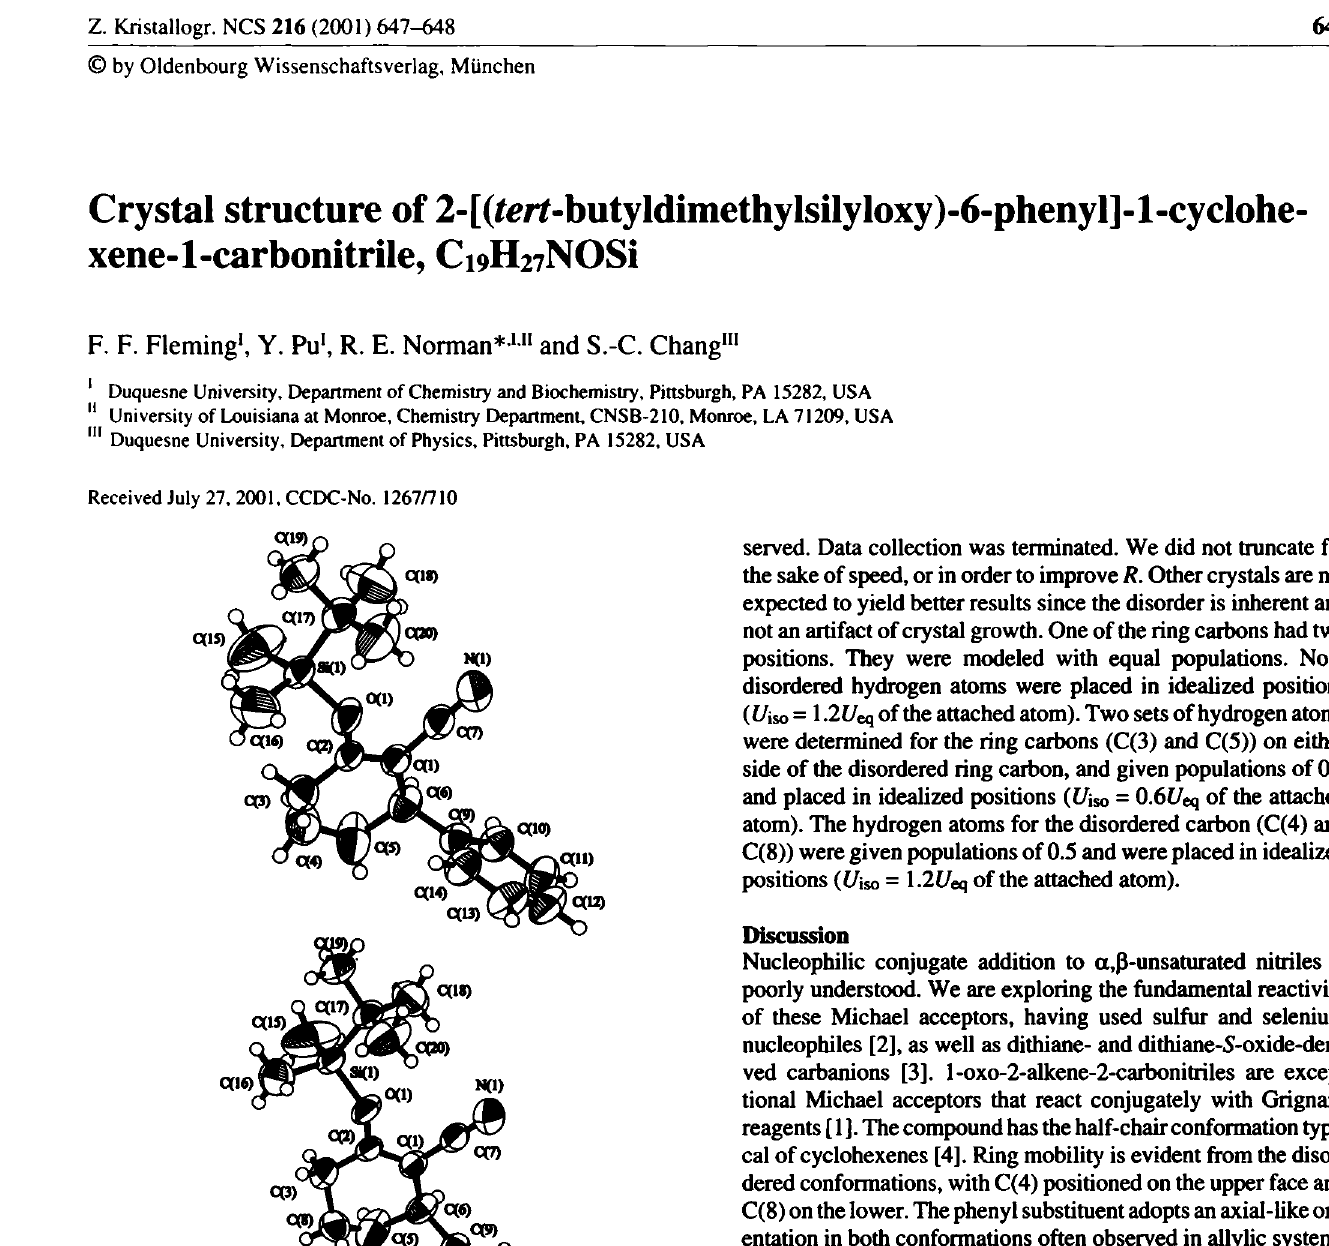
Table 1. Data collection and